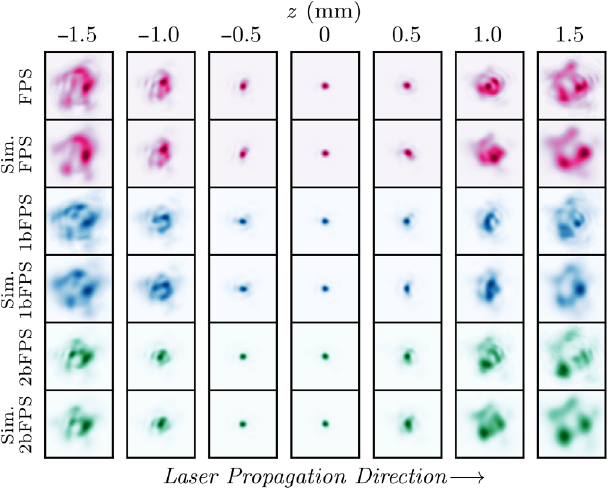
FIG. 2. Laser energy distribution in the transverse plane around the focal position — relative position marked above — for three different settings of the AO and their corresponding energy profiles displayed from their modal description used in the simulation (denoted by Sim. ). Flat phase setting (FPS) and two manually altered AO setting fluence profiles, 1bFPS and 2bFPS, are displayed in pink, blue, and green, respectively. Each image is normalized to its maximum value for visibility.